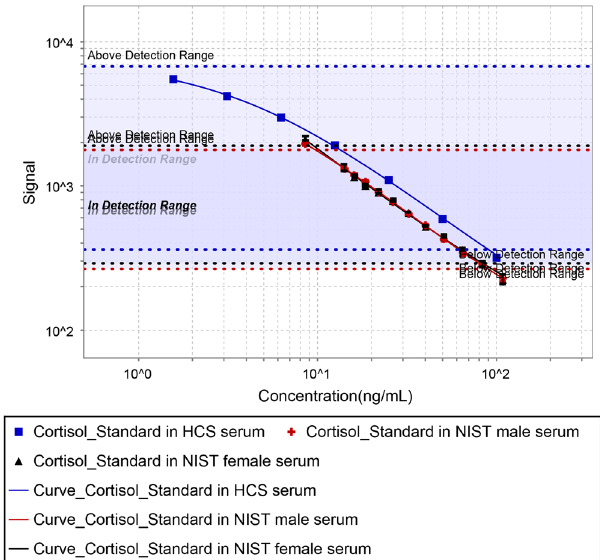
Figure 2. Cortisol standard curves in diluent and test plasma. The 4 parameter logistic fit of the cortisol standard curve in a background of (blue line) 12-fold diluted heavy charcoal stripped (HCS) serum, (red line) 12-fold diluted NIST male serum (NIST 971) and (black line) 12-diluted NIST female serum (NIST 971), using NIST cortisol CRM 921 as the